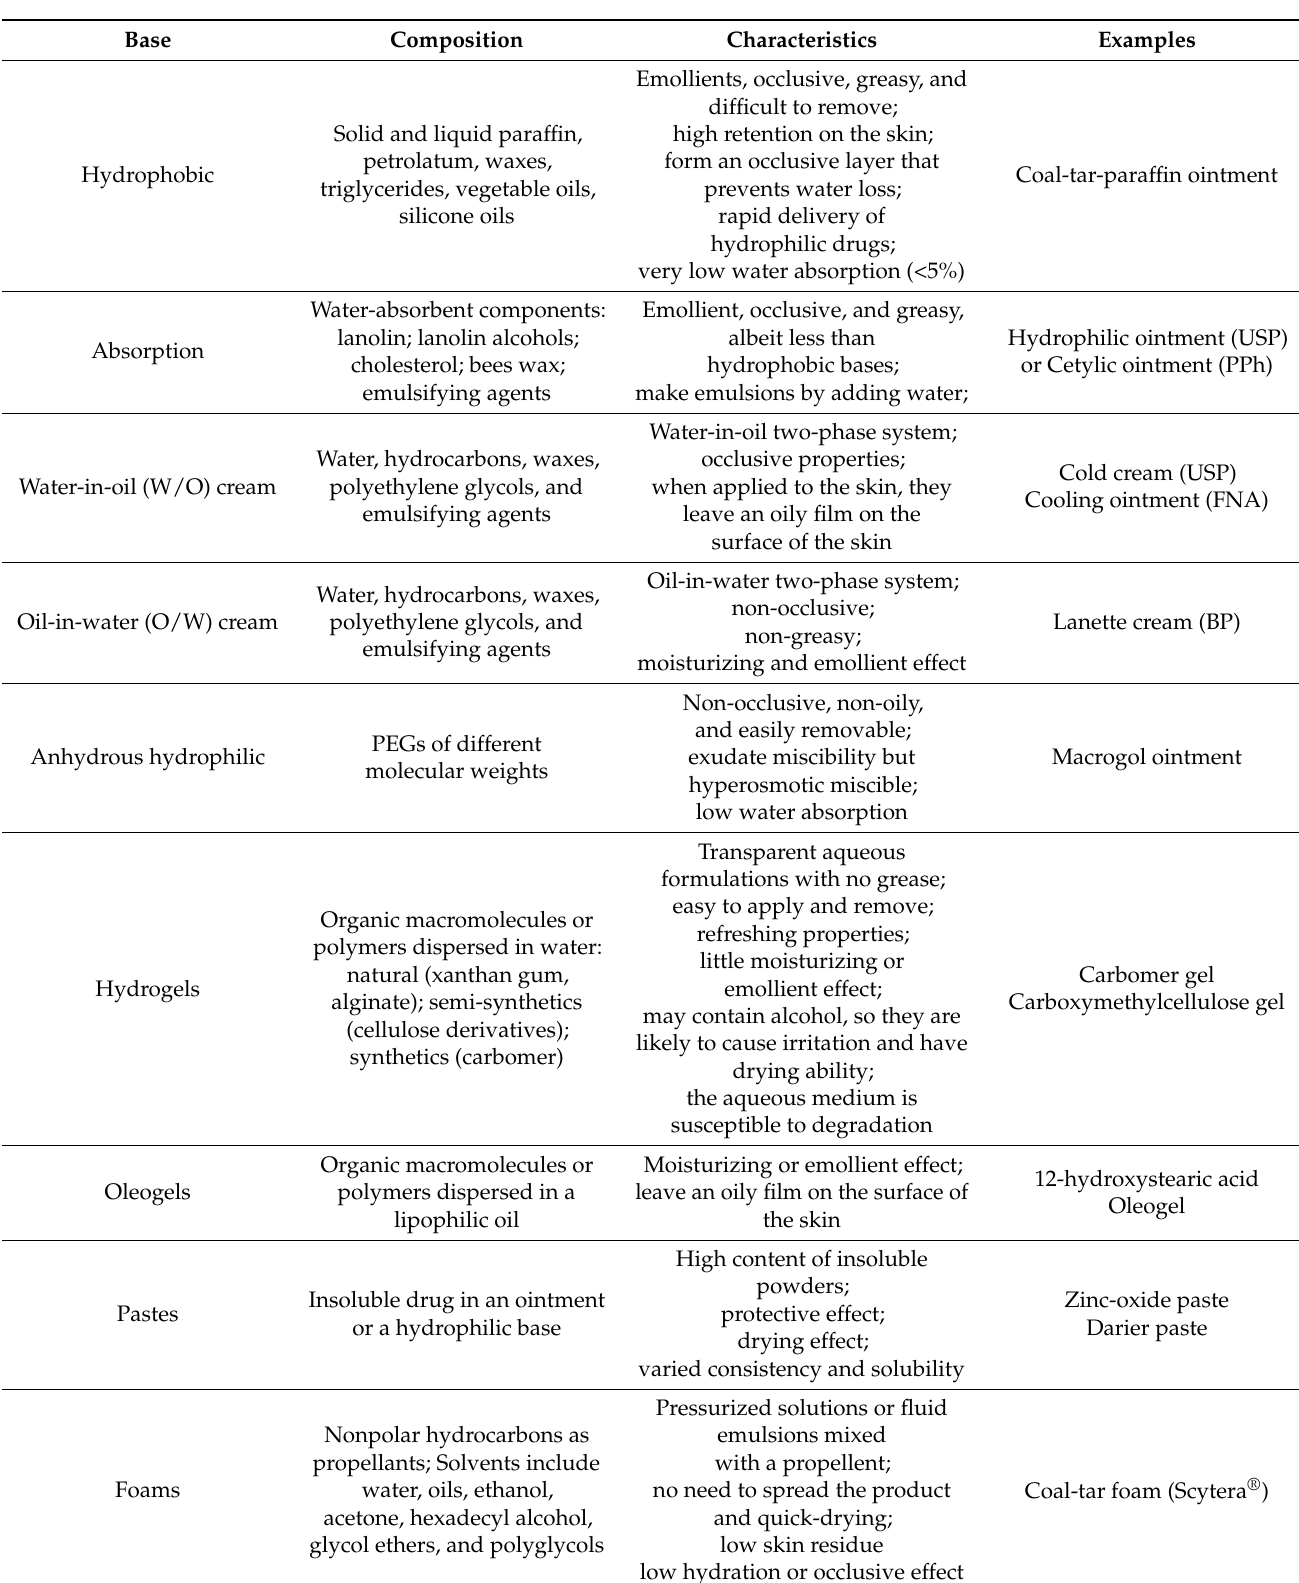
Table 2. Characteristics of semisolid bases